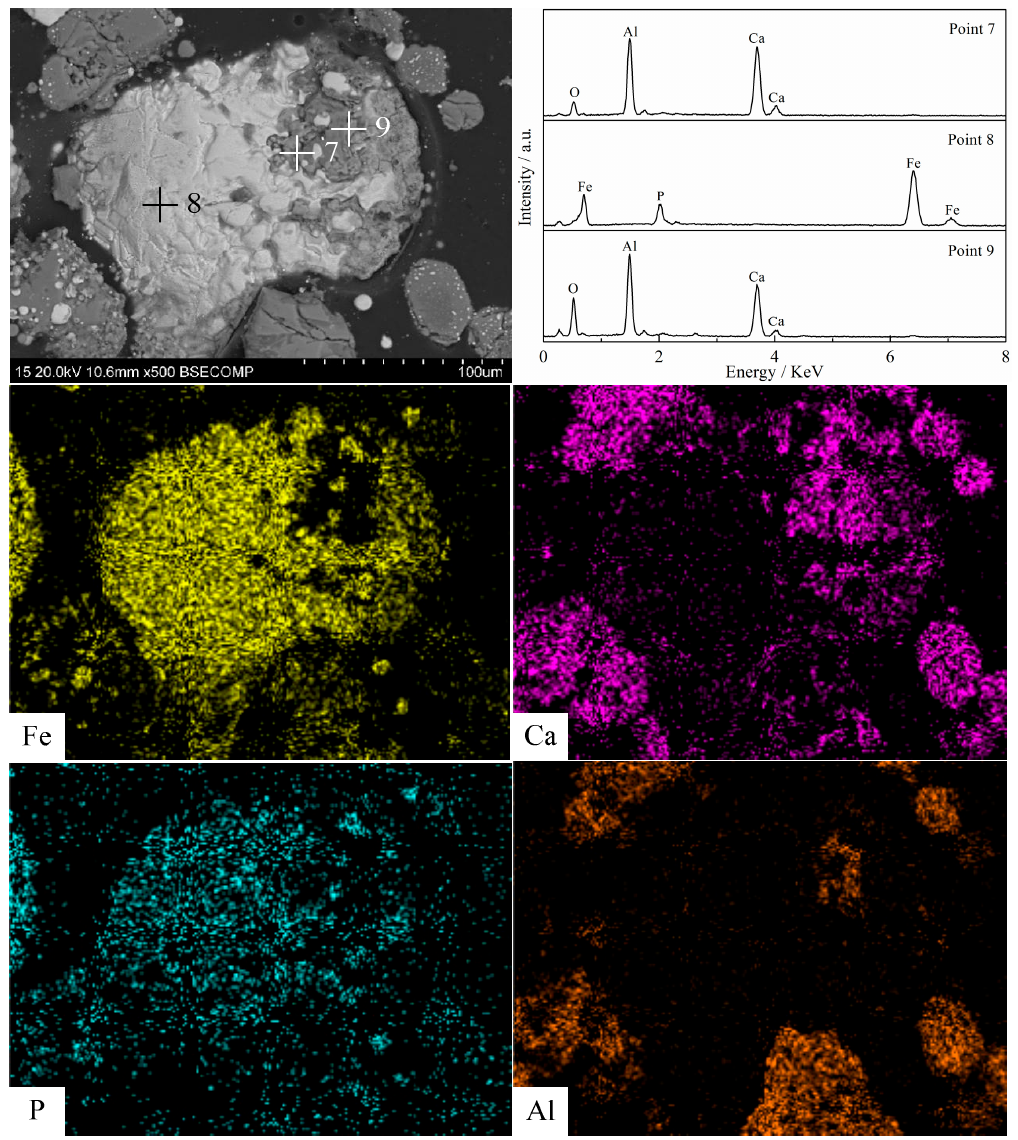
Figure 13. SEM image and EDS spectra and line-by-line scanning analysis of the reduction product in